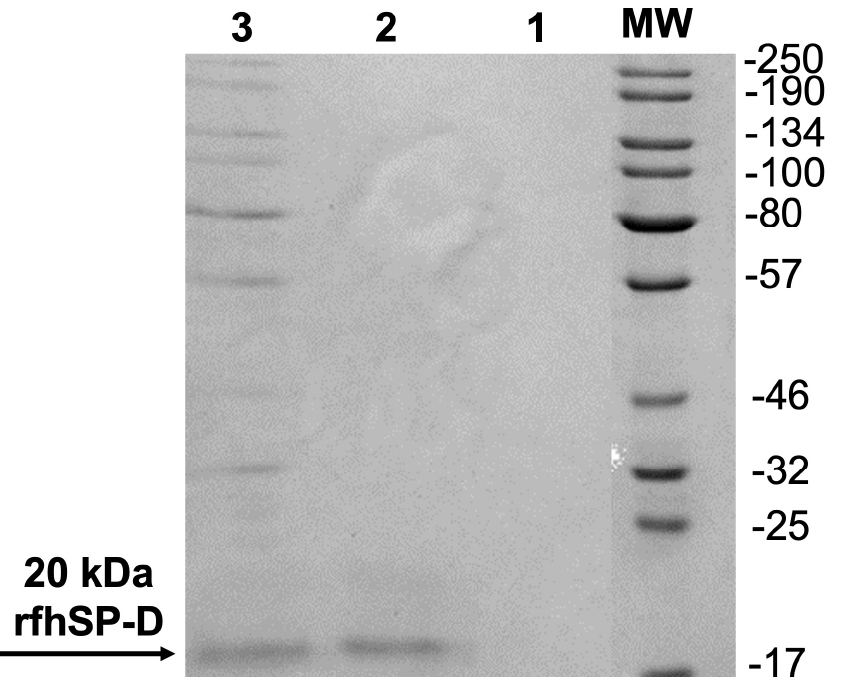
Figure 1. Purified rfhSP-D (10 µ g/mL) or carboxymethyl cellulose-coated carbon nanotubes (rfh-SP-D-CNTs) coupled-rfhSP-D (10 µ g/mL) samples were subjected to an SDS-PAGE (15% v / v ). Lane 1: Supernatant (10 µ L/well) taken after centrifugation of rfhSP-D-CNT. Lane 2: purified rfhSP-D. Lane 3: rfhSP-D-CNT. The original image is available as a supplementary material.